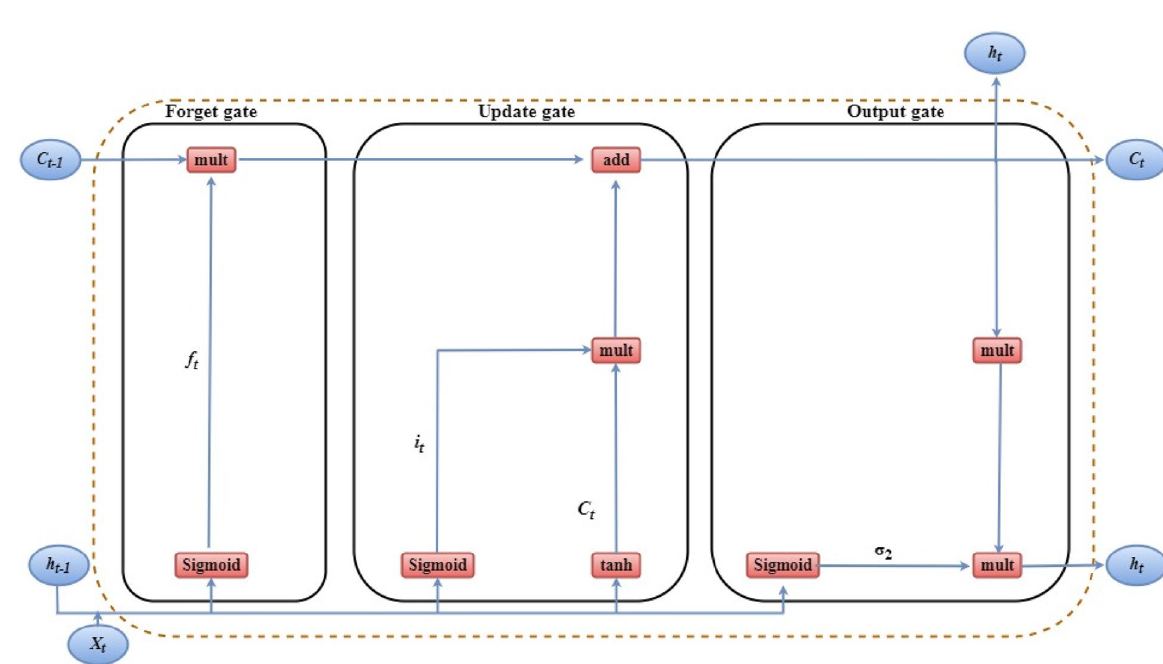
Figure 3. The internal structure of long short-term